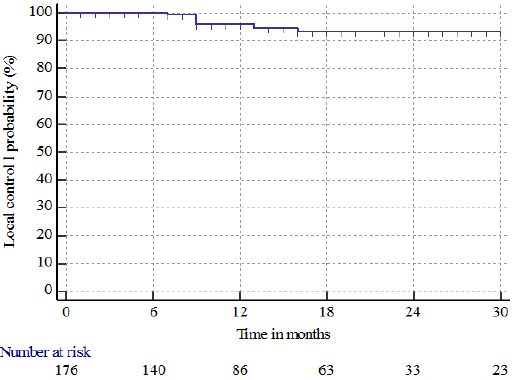
Figure 1. Local control (LC) of brain metastases in patients with renal cell carcinoma treated with radiosurgery in single or multifraction (SRS/HSRS) or surgery followed by HSRS. Brain distant failure (BDF) occurred in 35 (29.2%) patients at a median time of 10 months (range 1–113 months). The median BDF time and 6 month and 1, 2, and 3 year BDF rates were n.r., 11.9% ± 3.1%, 25.1% ± 4.5%, 38.7% ± 5.5%, and 44.4% ± 6.3%, respectively. The median PFS time and 6 month and 1, 2, and 3 year PFS rates were 5 months (95% CI: 4–8), 50% ± 4.5%, 30% ± 4.1%, 9.9% ± 2.8%, and 4.1% ± 2.1%, respectively. The median OS time and 6 month and 1, 2, and 3 year OS rates were 16 months (95% CI: 12–22), 80% ± 3.6%, 58.3% ± 4.5%, 30.9% ± 4.3%, and 16.9% ± 3.6%, respectively. At the last observation time, 17 (14.2%) patients were alive, and 103 (85.8%) were dead, three (2.9%) from intracranial progression, 90 (87.4%) from extracranial progression, eight (7.8%) from extracranial and brain progression, and two (1.9%) from a tumor-unrelated cause. Figure 2 shows the BDF, PFS, and OS for all patients treated.